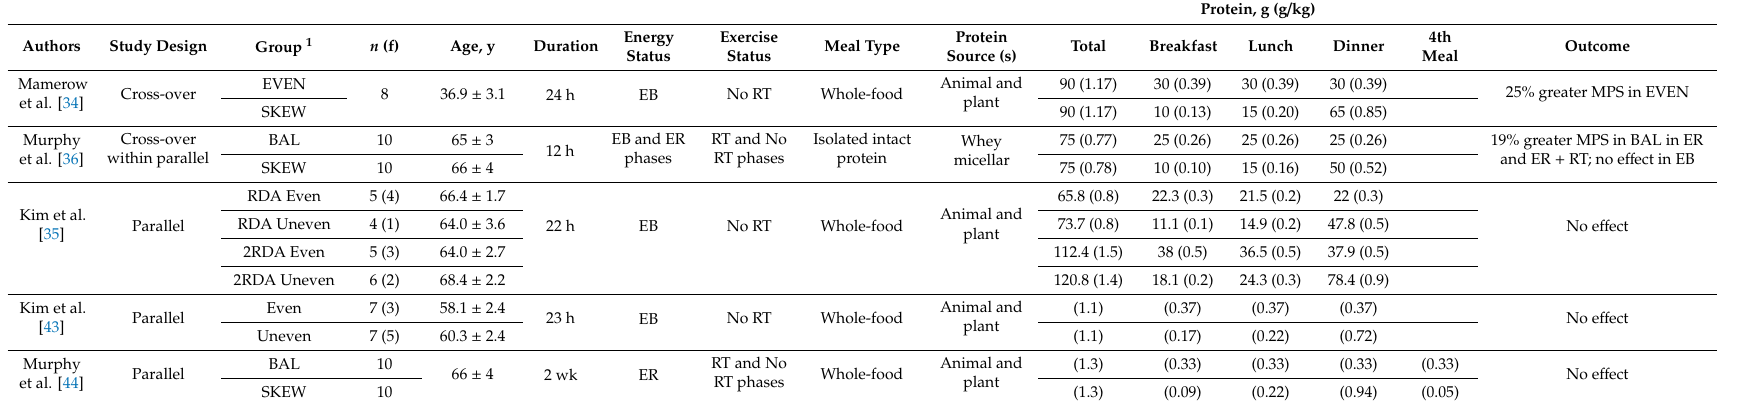
Table 2. Acute randomized controlled protein ingestion